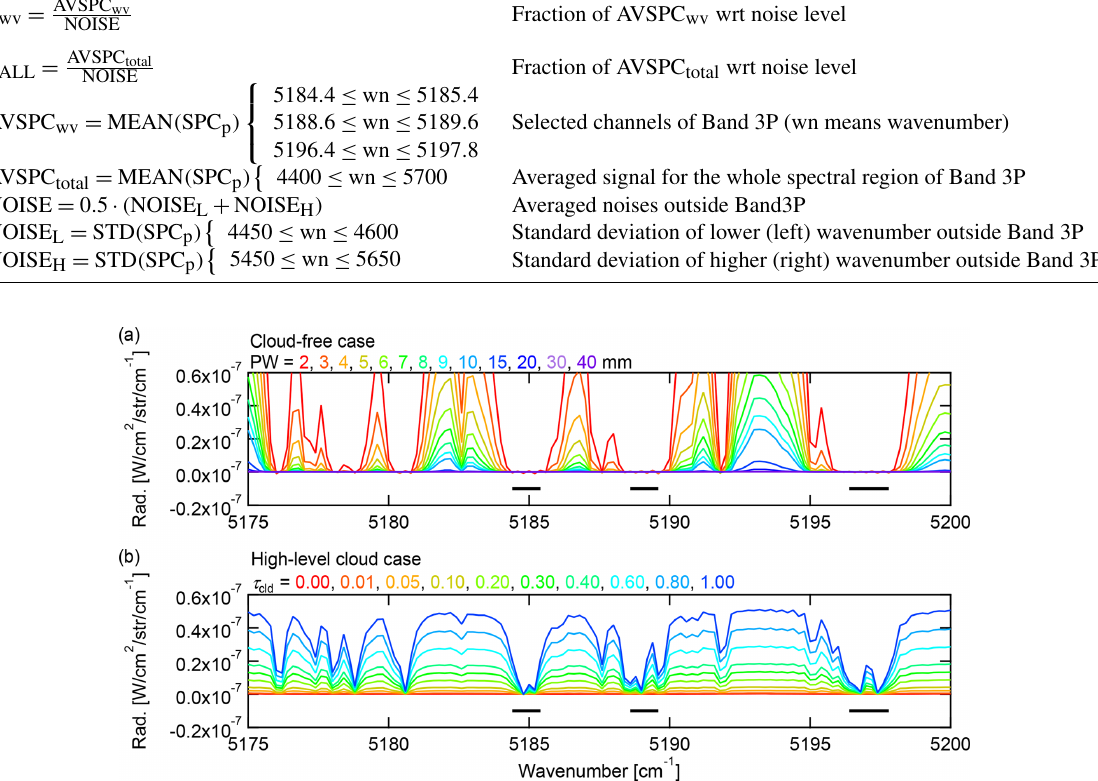
Figure 2. Simulated spectra for (a) cloud-free cases for different precipitable water vapor amounts and (b) high-level cloud cases for different cloud optical thicknesses. A Lambertian surface with albedo of 0.3 is assumed. Solar zenith angle and satellite zenith angle are set to 30 and 0 ◦ (nadir viewing), respectively. The horizontal black bars show 5184.4–5185.4, 5188.6–5189.6 and 5196.4–5197.8cm − 1 ,